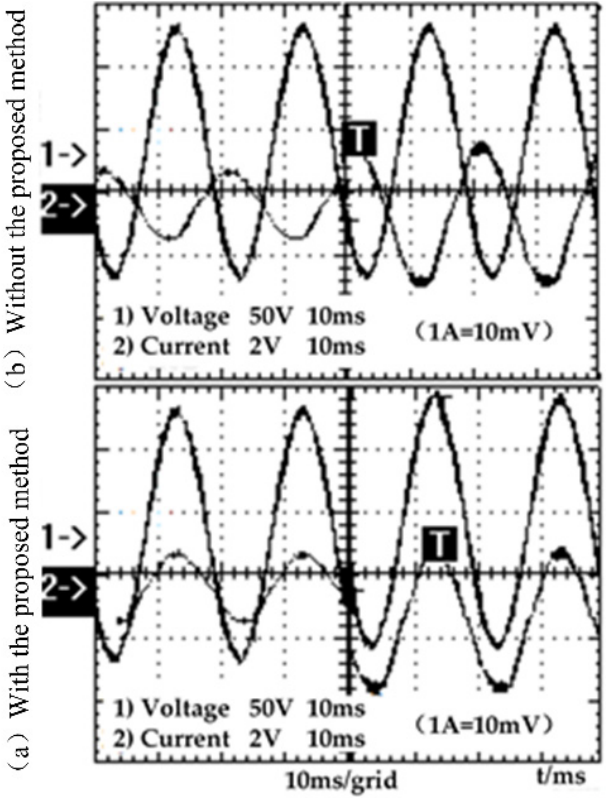
Figure 11. SVG Waveforms of U–I relation when load changing.